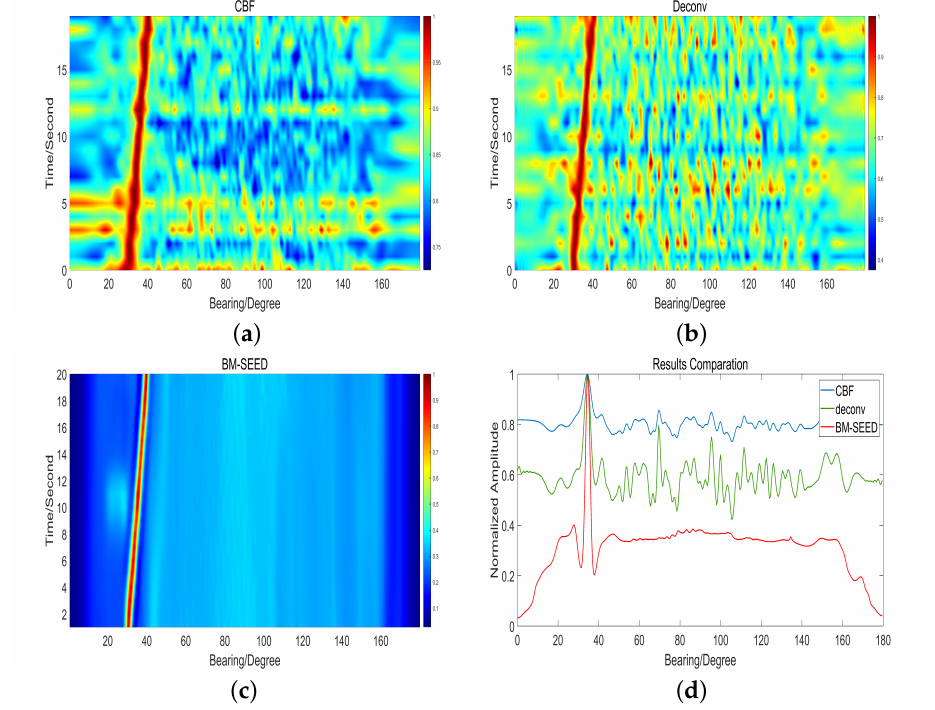
Figure 7. Experiment Results under − 25 dB SNR. ( a ) CBF result under − 25 dB SNR; ( b ) Deconv result under − 25 dB SNR; ( c ) BM-SEED result under − 25 dB SNR; ( d ) Results-Comparasion under − 25 dB